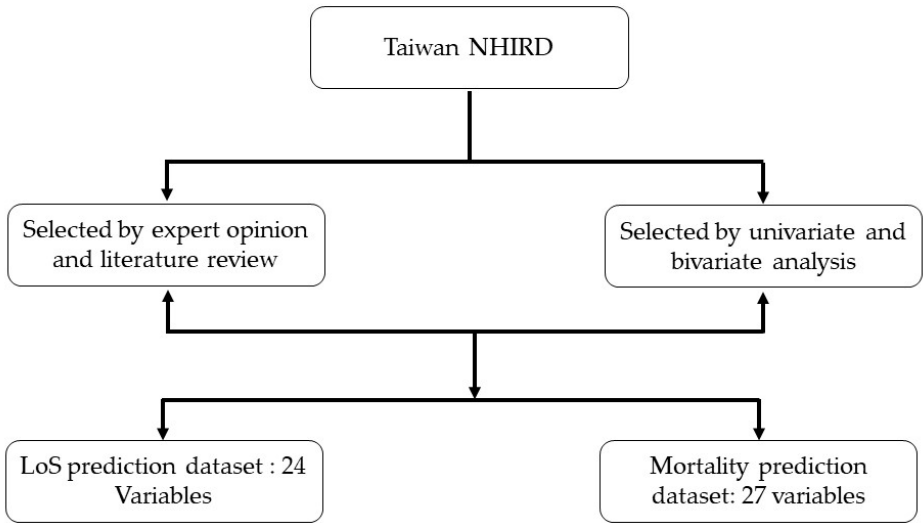
Figure 2. Feature selection process for LoS and mortality prediction.